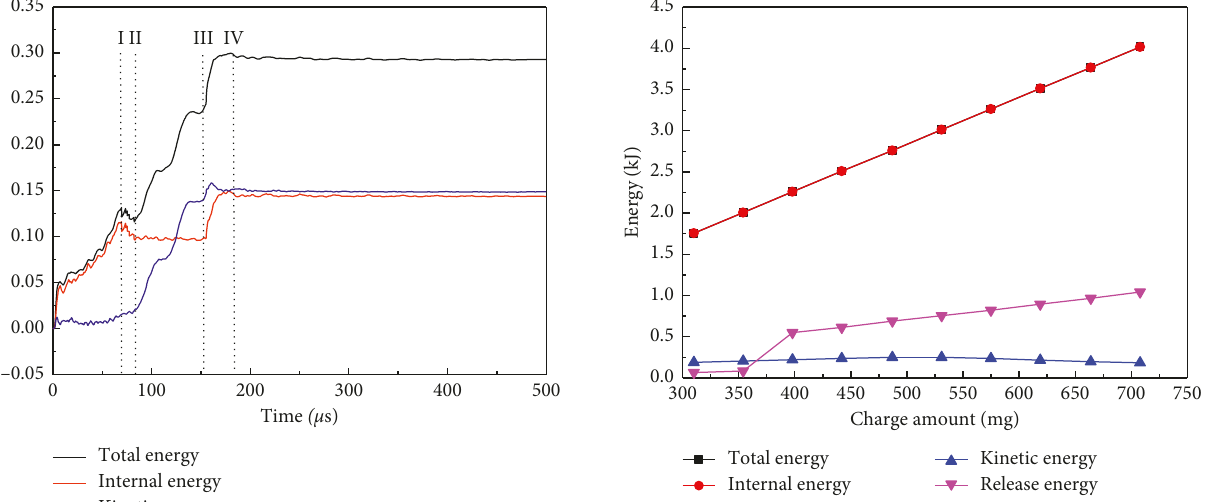
Figure 26: Peak energy curves of the charge amount.